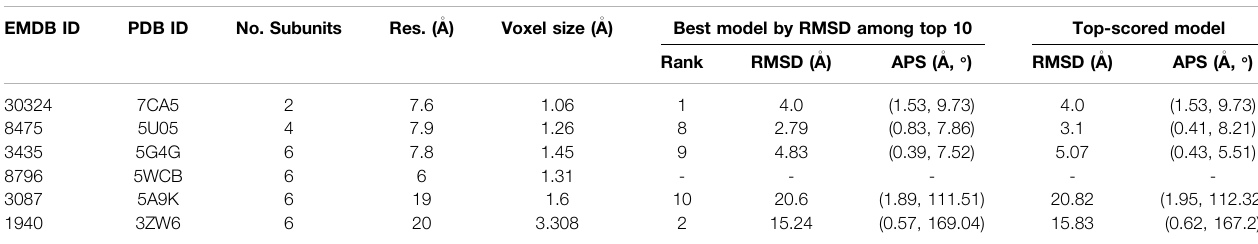
TABLE 5 | Modeling accuracy using AlphaFold2 subunit models. EMDB